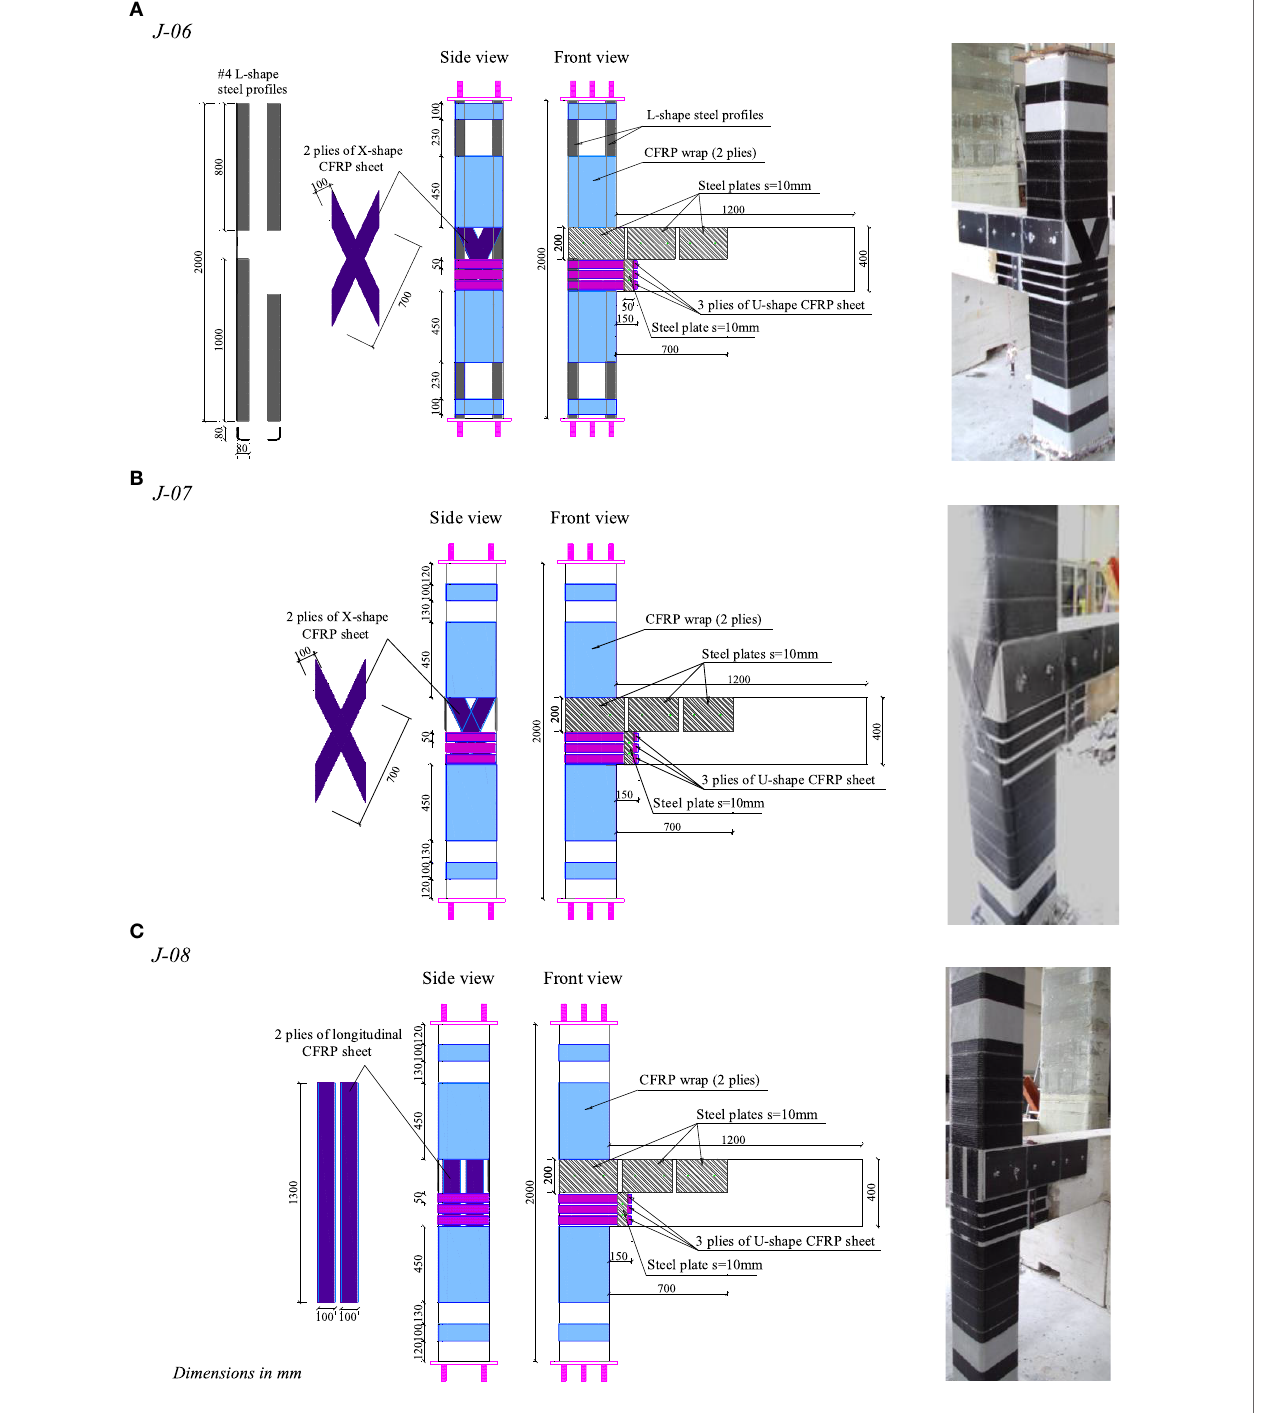
FIGURE 4 | Carbon fiber reinforced polymer (CFRP) strengthening schemes: specimens J-06 (A) , J-07 (B) , and J-08 (C) .